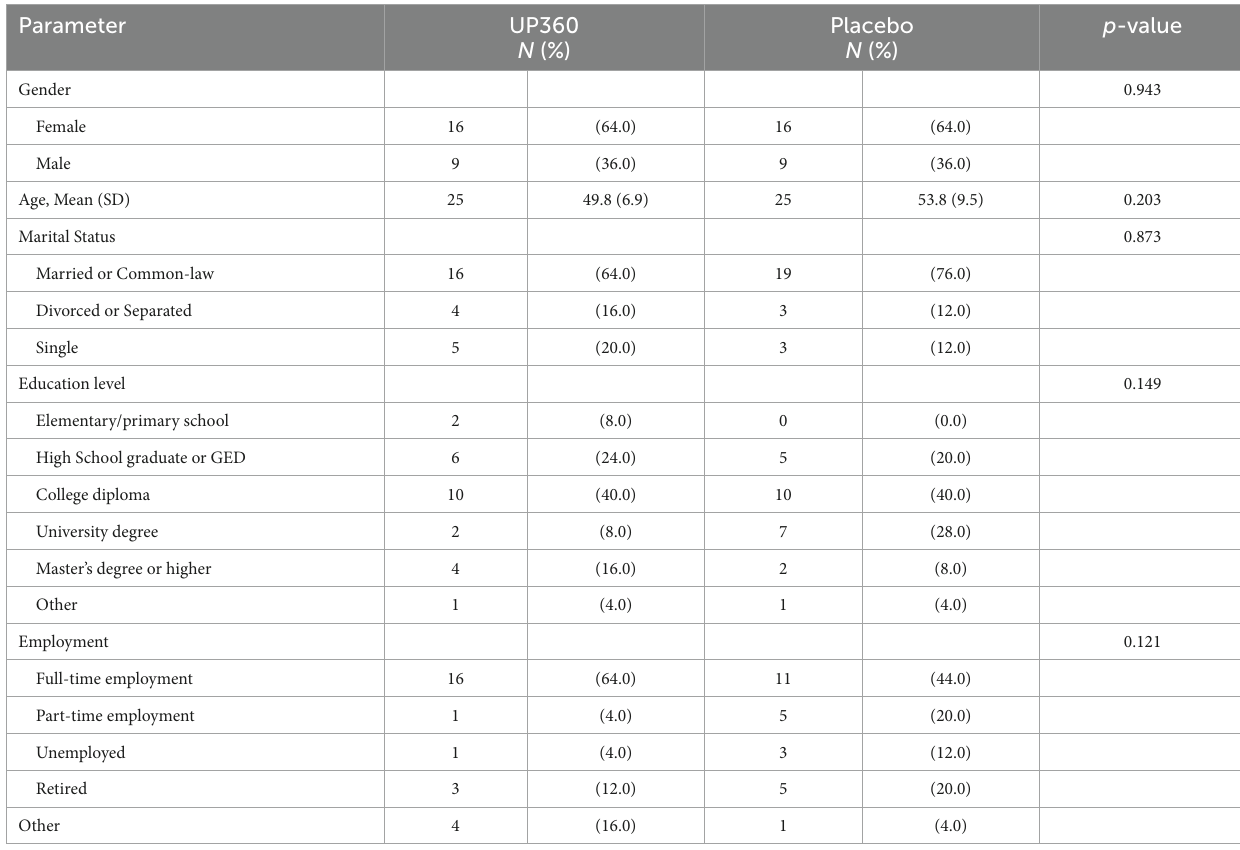
TABLE 1 Baseline demographic for participants ( n =